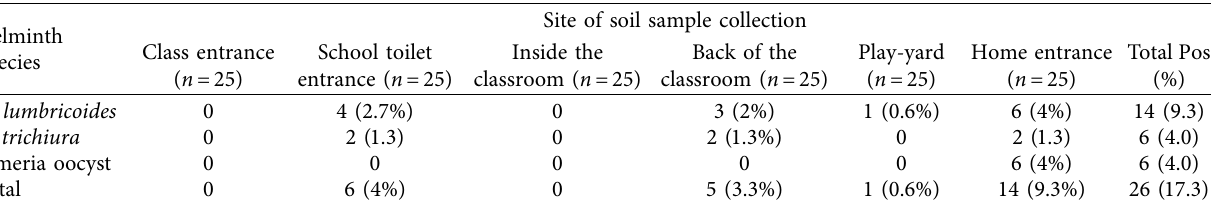
Table 4: Parasitic contamination of soil ( n � 150) at Kola Diba primary school, Northwest Ethiopia. Helminth